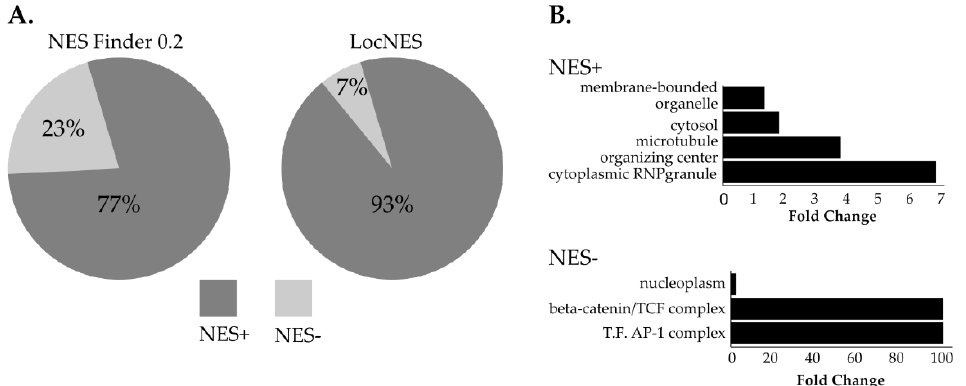
Figure 4. Screening of nuclear export signals (NESs) in NHA9-BioID proximal interactors. The amino acid sequences of the 131 NHA9-BioID proximal interactors were analyzed by two di ff erent algorithms (NES Finder 0.2 and LocNES) to evaluate the presence of classical NES. ( A ) The results from both algorithms show that the majority of NHA9-BioID proximal interactors have at least one putative classical NES, with a higher percentage of NES + proteins determined by the LocNES algorithm. ( B ) GO analysis of NES + and NES- proteins identified by NES Finder 0.2 shows an overrepresentation of proteins from cytoplasmic RNP granules and the microtubule organizing center. NES-